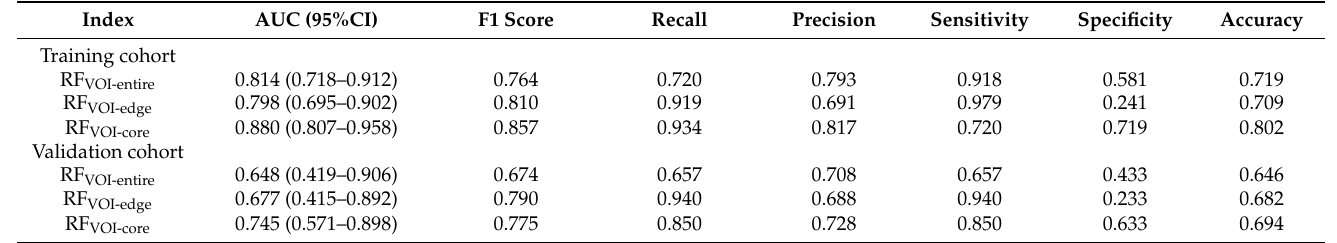
Table 2. The performance of the RF classifier is based on multiregional VOIs to distinguish RANKL states in the training cohort and validation cohort.